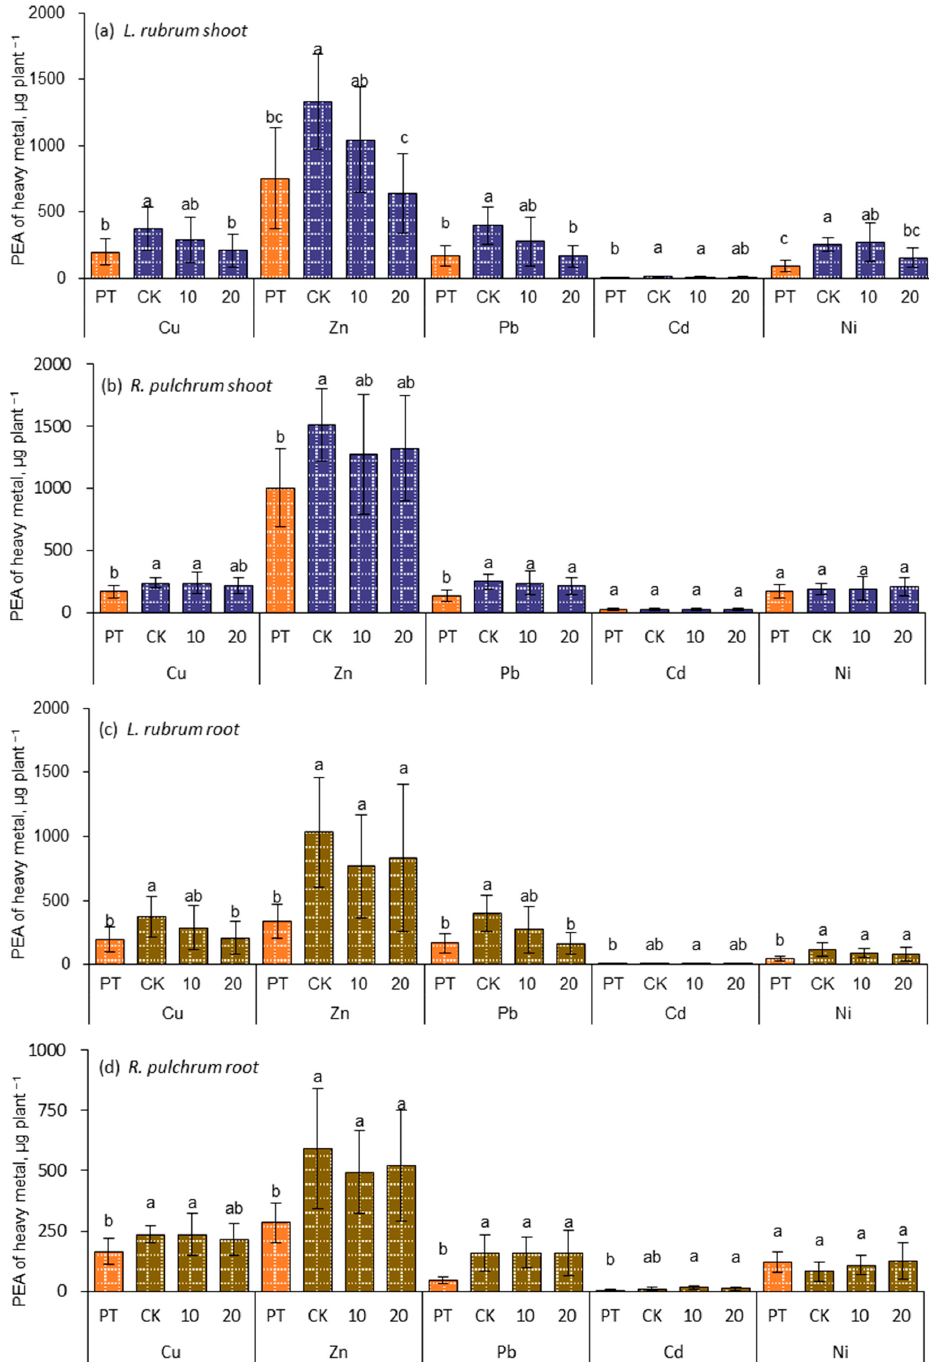
Figure 7. Heavy metal accumulated in the shoot and root of the garden plants, ( a , b ) are the plant extraction amount of heavy metals in the shoot of L. rubrum and R. pulchrum , and ( c , d ) are the plant extraction amount of heavy metals in the roots of L. rubrum and R. pulchrum . Different letters indicate significant differences among the treatments, p < 0.05. The posthoc test was performed with Tamhane method. PT indicates samples of pre-treatment, while CK, 10, and 20 are IAA treatments at 0, 10, and 20 mg L − 1 , respectively.